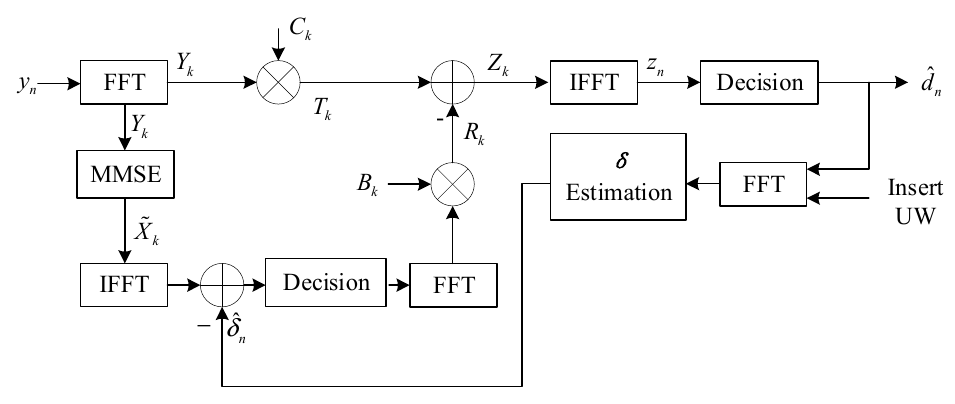
Figure 5. Schematic diagram of E-IBDFE.